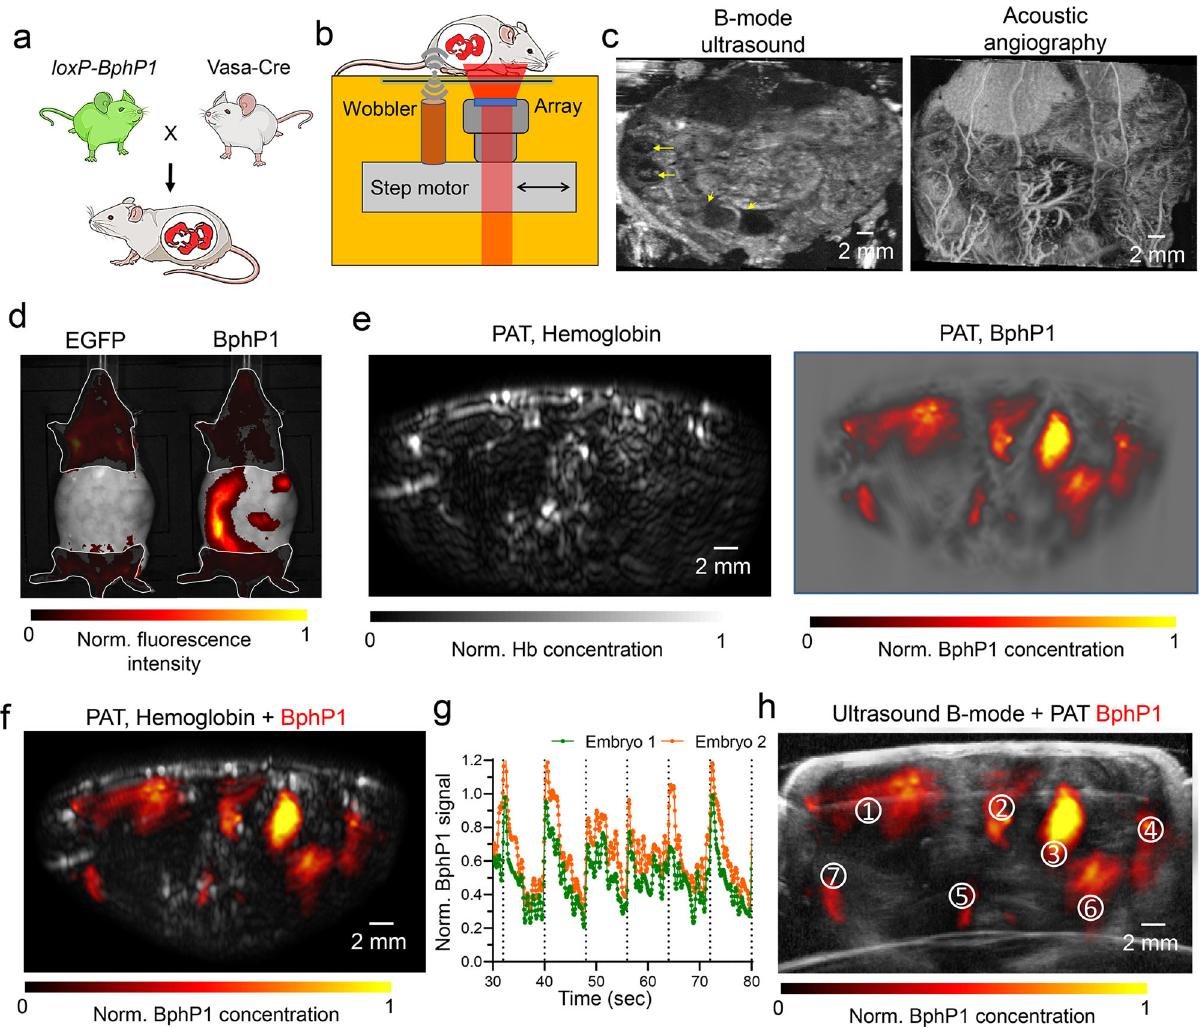
Fig. 6 Non-invasive PA imaging of BphP1-expressing embryo in vivo. a A loxP-BphP1 male mouse was crossed with a Vasa-Cre female mouse. All the embryos in the pregnant female mouse were expected to express BphP1. b Schematic of the hybrid PA and ultrasound imaging system, in which the linear ultrasound array for PA imaging and the focused wobbler are installed on the same translation motor stage. c The ultrasound image and acoustic angiographic image of the pregnant Vasa-Cre mouse show multiple embryos distributed at different depths. d IVIS Spectrum images of the pregnant Vasa- Cre mouse, showing no EGFP expression, but BphP1 expression. BphP1 intrinsic fl uorescence (Ex. 665 nm, Em. 725 nm) and EGFP fl uorescence (Ex. 480 nm, Em. 535 nm). e PAT images of hemoglobin signals in the major maternal organs, and BphP1 signals in all seven embryos. f Overlayed image of the hemoglobin signals (shown in gray) and the BphP1 signals (shown in color). g Robust photoswitching of the BphP1 signals from two embryos. h Overlay image of the ultrasound image (shown in grey) and BphP1-expressing embryos (shown in color). For more details, see “ Statistics and reproducibility ” section of the